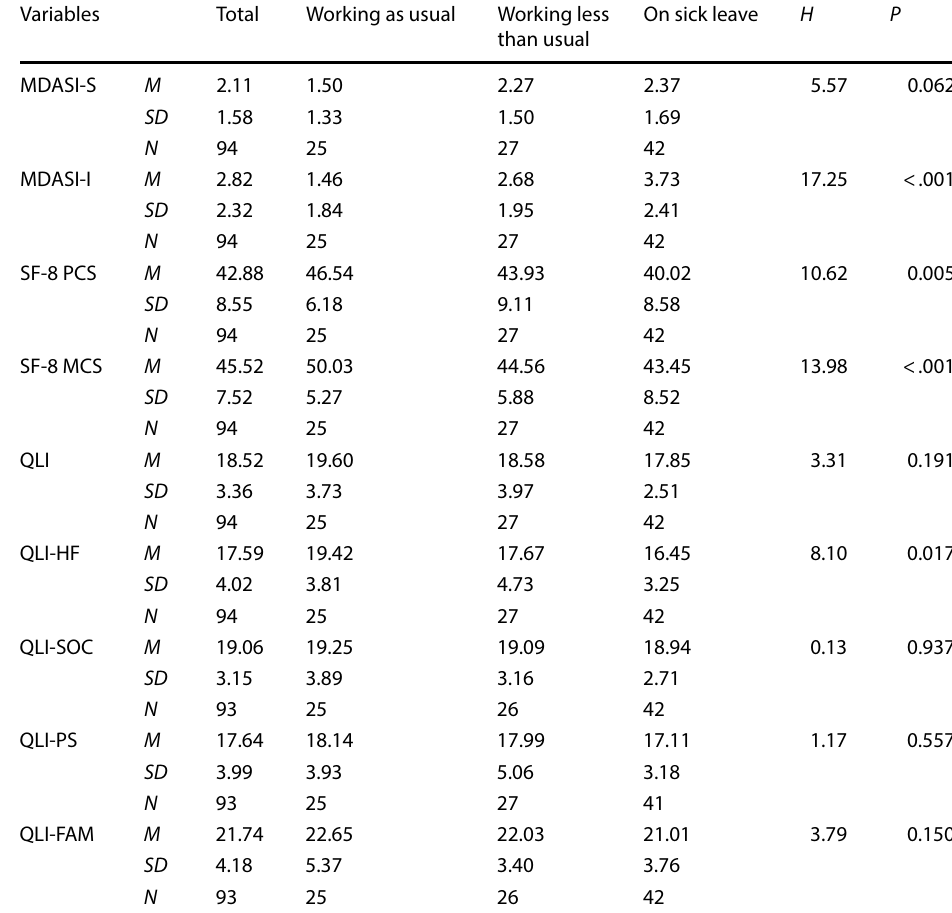
Table 3 Summary of means, standard deviations, and differences of scores of HR-QOL scales on return-to- work